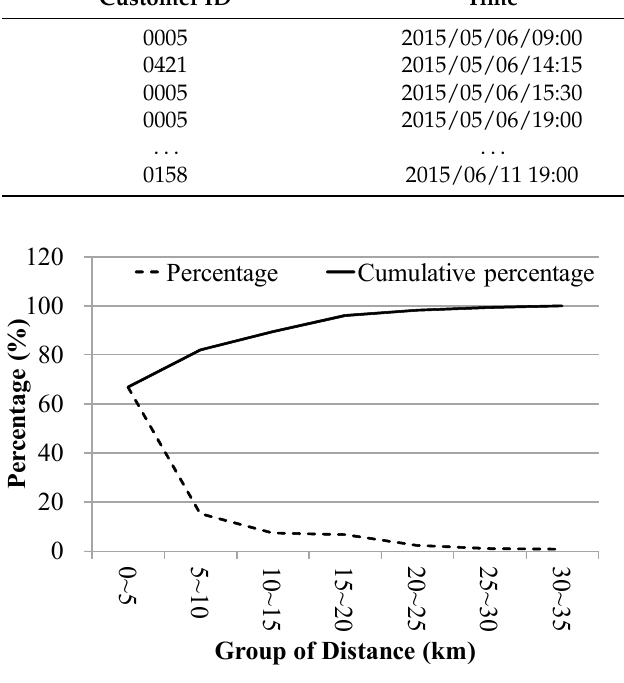
Figure 4. An example of finding a proper distance threshold.